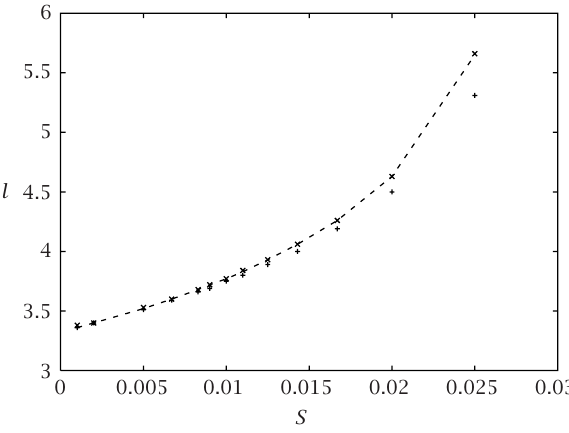
Figure 5.1 . Comparison of 1D and 2D simulations. The lower crosses repre- sent 1D model; the upper crosses and the dashed line represent 2D model. Table 5.1 . Comparison of numerical results with different numbers of dis- cretization